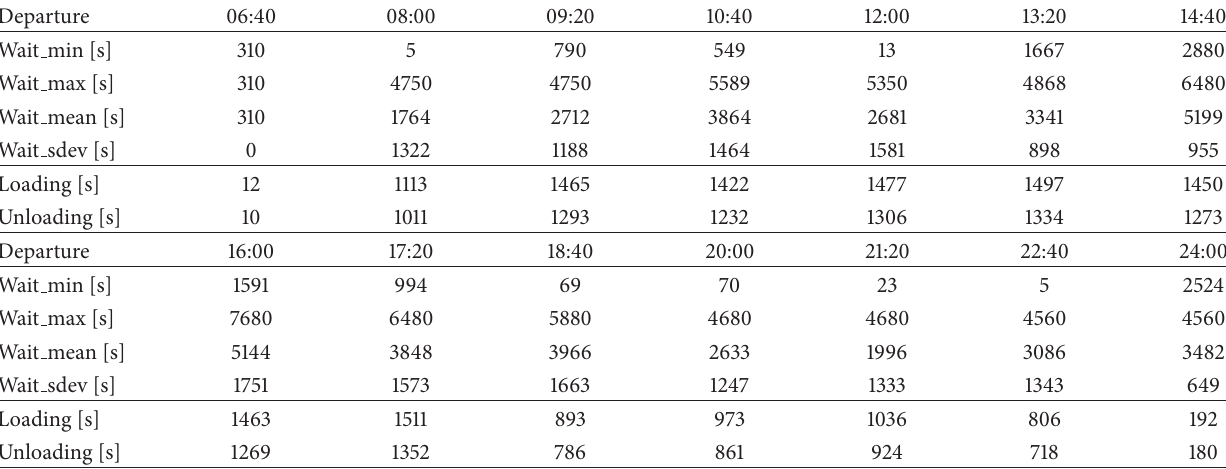
Table 7: Waiting times for loading/unloading operations, second